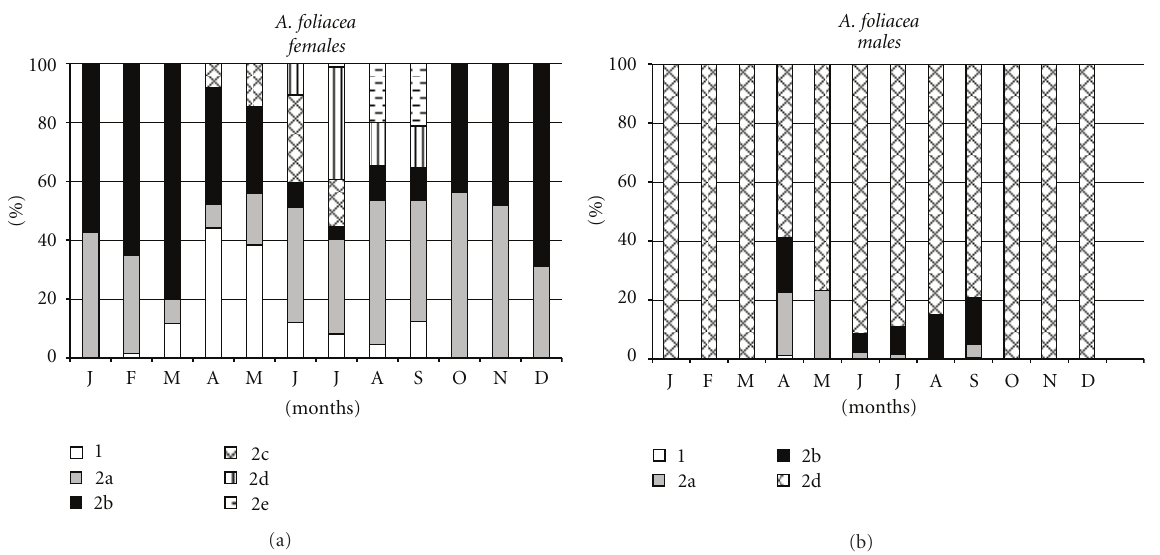
Figure 3: Monthly occurrence of ovarian maturity stages of females (a) and males (b) of Aristaeomorpha foliacea from the southern Tyrrhe- nian Sea.